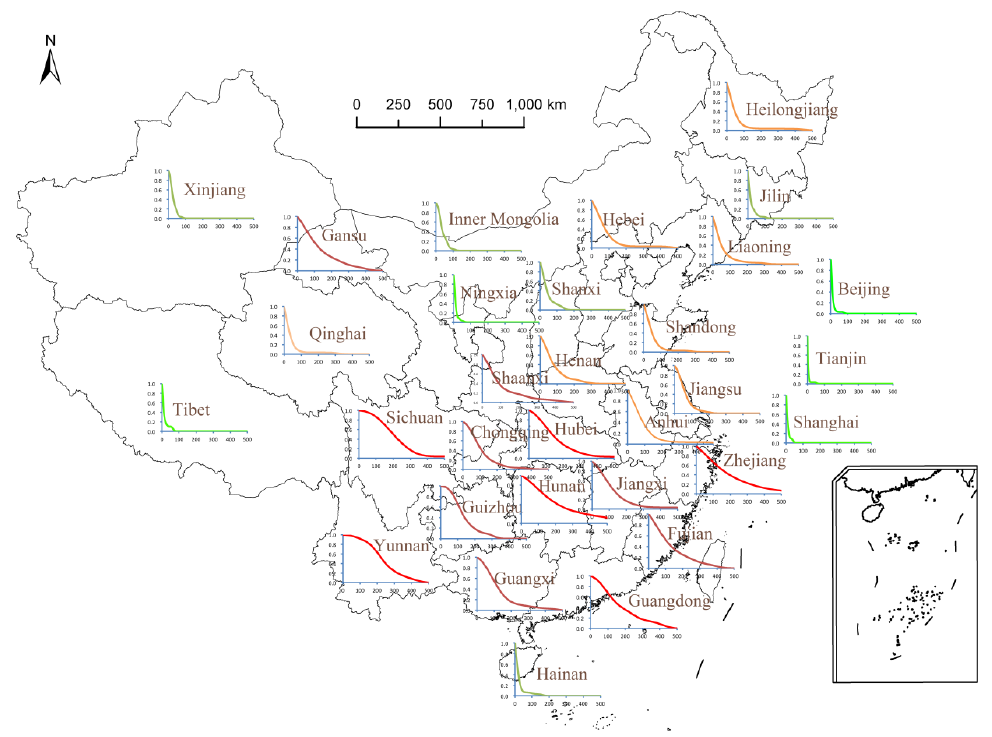
Figure 2. Risk curves of multiple hazards for each province (municipality, autonomous region) in China.